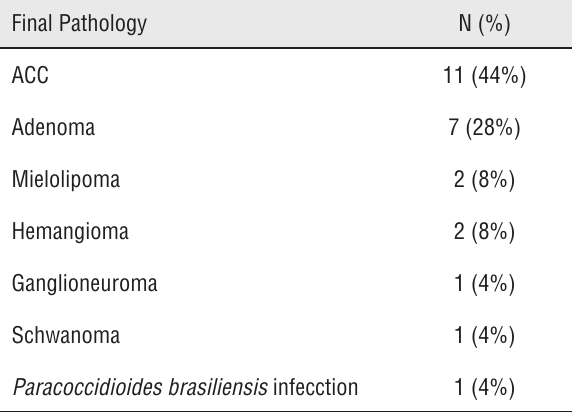
Table 2 – Final pathology of large adrenal masses suspect of adrenocortical carcinoma at diagnosis